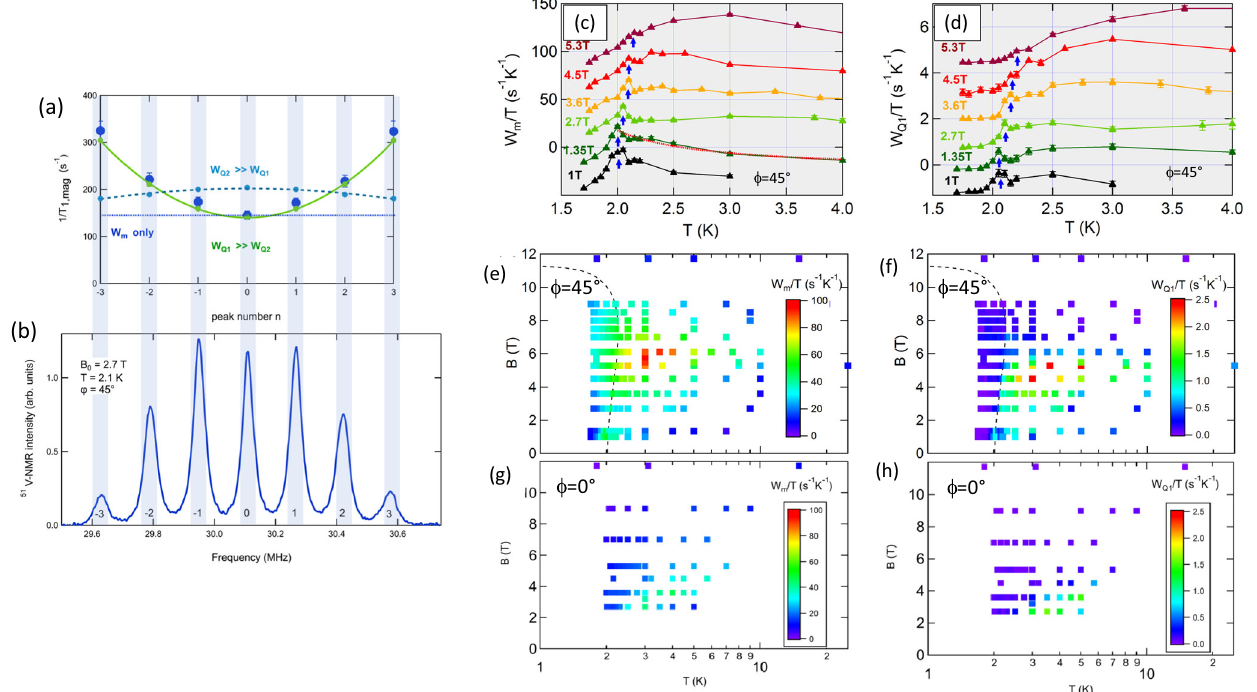
¼ 2 W Fig. 3 Magnetic and quadrupolar relaxation rates for in-plane fi elds. a Plot of the magnetic relaxation rate T (cid:2) 1 m (large blue circles) 1 ; mag with strongly enhanced relaxation rates on the outermost satellites ( n = ±3) at B 0 = 2.7 T and T = 2.1 K. Purely magnetic relaxation should give identical T (cid:2) 1 for all peaks (horizontal line). Fits to magnetic relaxation only of simulated relaxation curves that include W Q 1 = 2.3 s − 1 and 1 ; mag W Q 2 = 0 reproduce the upward curvature of T (cid:2) 1 . Inclusion of W Q 2 = 2.3 s − 1 , but W Q 1 = 0 leads to downward curvature. Lines are quadratic 1 ; mag fi ts and vertical bars link relaxation data with the corresponding transitions of the NMR spectrum. Error bars indicate standard deviations. b Spectrum of FIB sample at B = 2.7 T and T = 2.1 K. c , d The magnetic and quadrupolar relaxation rates divided by temperature, W m / T and W Q 1 / T , versus T for small fi elds along ϕ = 45 ∘ . The data at each fi eld have been displaced vertically for clarity. Blue arrows are guides to the eye indicating T Q . The dotted red line is a fi t to Eq. (3) as described in the text with Θ = 1.18 K. Panels e , f show W m / T and W Q 1 / T plotted as heat maps over temperature and fi eld. At low fi elds, sharp anomalies at T Q = 2.15 K are visible and broaden and increase with increasing fi elds. Above B ~6 T both relaxation channels, especially W Q 1 / T , are rapidly suppressed. The dashed lines in the background of panels ( c , d ) are guides to the eye based on the computed T Q ( B ) shown in Fig. 2d. Panels ( g , h ) show W m / T and W Q 1 / T for the longitudinal direction ϕ = 0 ∘ . Unlike the data for ϕ = 45 ∘ , no sharp anomalies at T Q = 2.15 K are visible and the relaxation rates are always